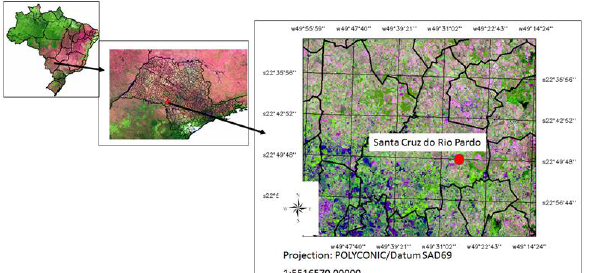
Figure 1. Guacho farm in the city of Santa Cruz do Rio Pardo.